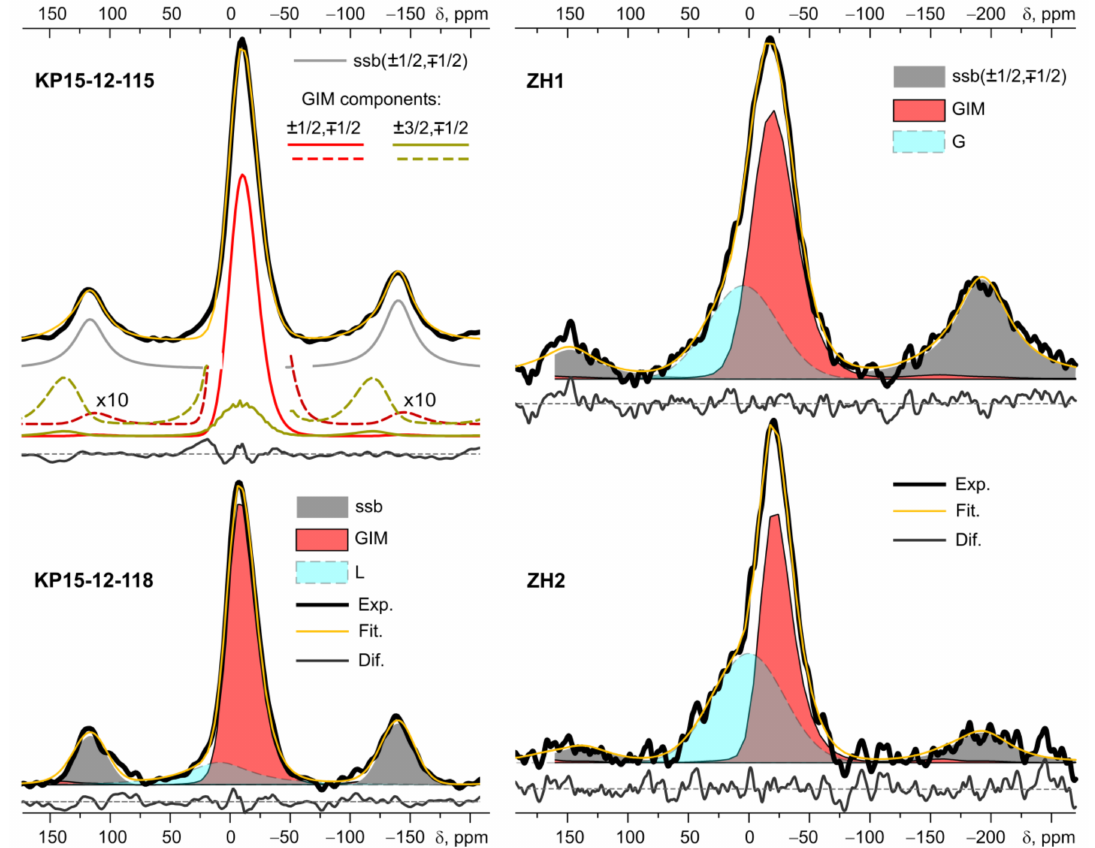
Figure 7. Deconvolution of the 23 Na MAS NMR spectra: Exp.—experimental spectra; Fit.—full deconvolution spectra; Dif.—difference (Exp.–Fit.); GIM–Czjzek component (all transitions of the central band and ssb); ssb—additional spinning sidebands approximated by the Voigt line shape; L or G—additional Lorentzian or Gaussian components of the central bands. For the KP15-12-115 spectrum, individual components for each of the transitions are shown, supplemented by a pair of lines (ssb ( ± 1/2, ± 1/2)), which compensates for the insufficient calculated intensity of the